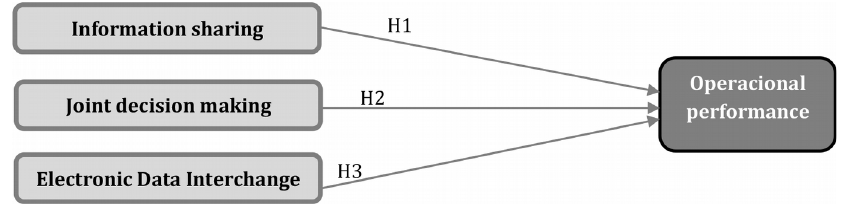
Figure 1. Research